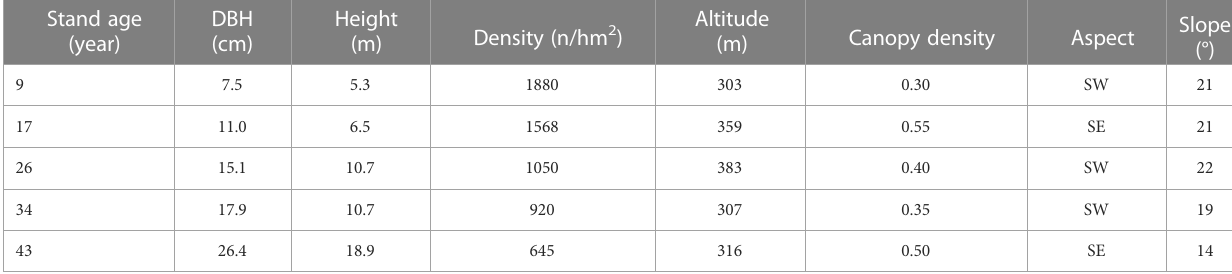
(Table 2). Soil moisture, total C, total N, DOC, DON and available P were signi fi cantly higher in the 34- and 43-year-old plantations in comparison to the 9-and 17-year-old plantations ( p <0.05). Soil total P and NH + 4 − N increased from stand age 7 to 34 and then increased with increasing stand age ( p <0.05).